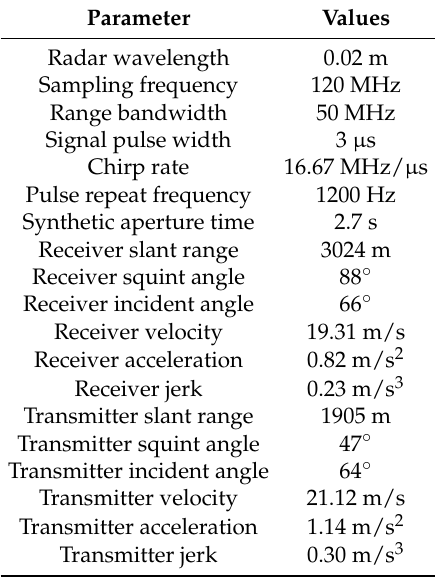
Table 1. SAR system